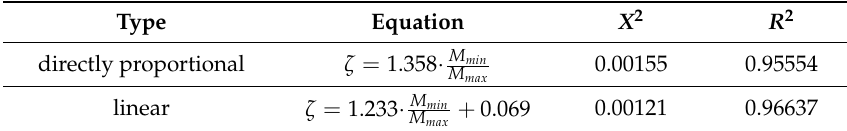
Table 2. Regression analysis of the experimental data.